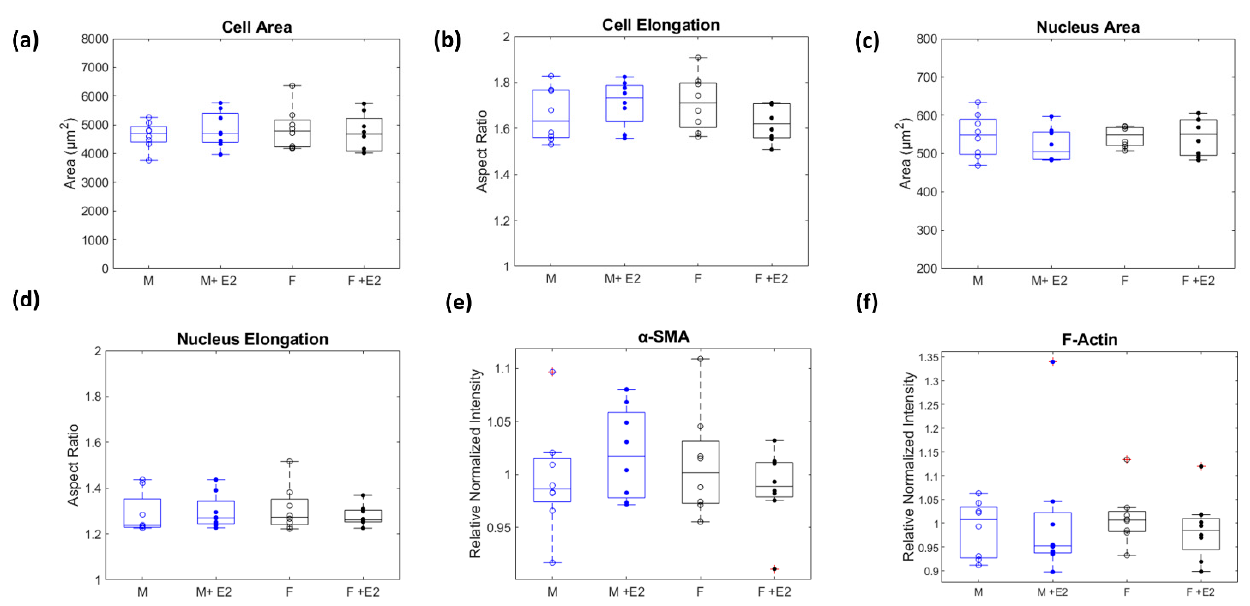
Figure 3. A two-way ANOVA was used to determine if there was any significant interaction ( α = 0.05) between sex (male = blue and female = black) and estrogen treatment (baseline = open dots to represent median of biological replicates and +E2 = closed dots) on morphological factors. No significant difference existed within groups or interaction between groups for total cell area and elongation ( a , b ), nor nucleus area and elongation ( c , d ). F-Actin and α -SMA relative protein levels did not significantly change between experimental conditions ( e , f ).